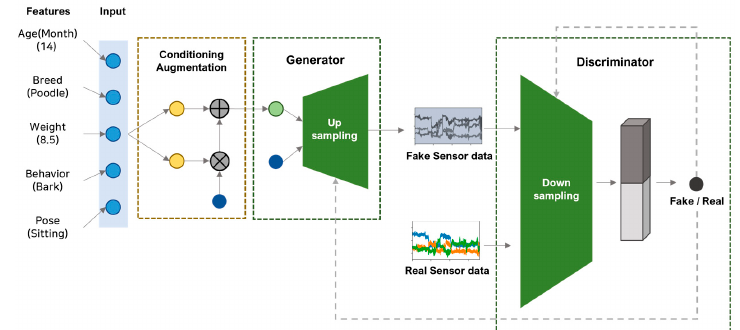
Figure 2. Data generation process of the TN-GAN.